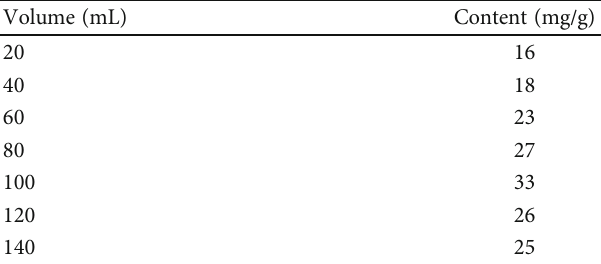
Table 4: E ff ect of tea ratio on brewing conditions. Volume (mL)